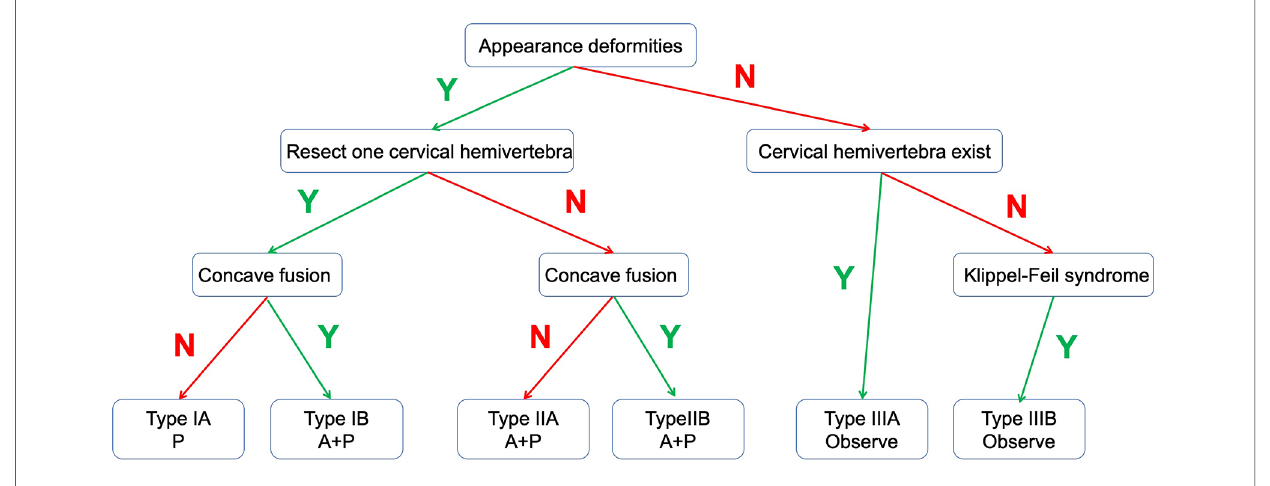
FIGURE 1 Algorithm for classi fi cation of subaxial cervical hemivertebra. Y, YES; N,